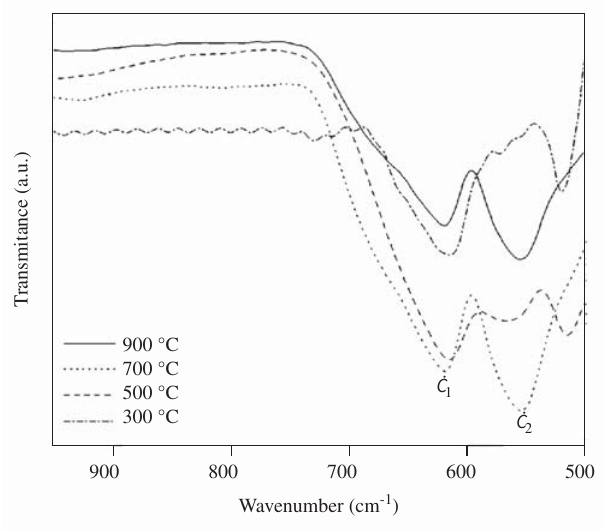
Santos CO, Leite ER, et al. Synthesis and characterization of Li spinel using the modified polymeric precursor method. Materials Chem- istry and Physics . 2003;